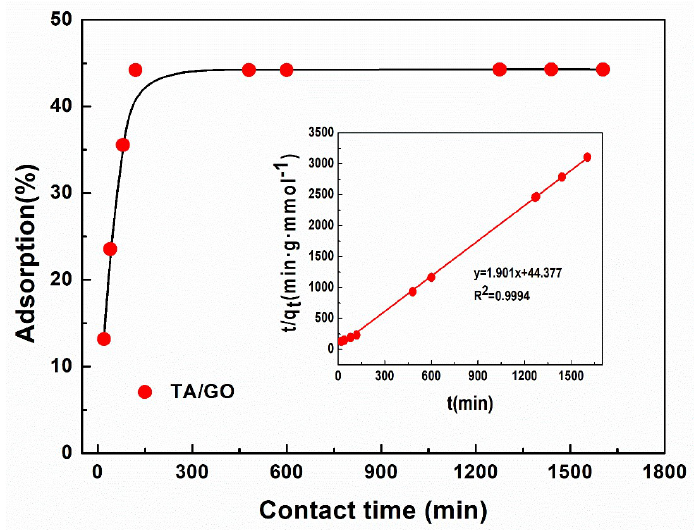
Figure 4. Time-dependent sorption at pH = 3.60 ± 0.05, m / V = 0.6 g / L, and I = 0.001 M